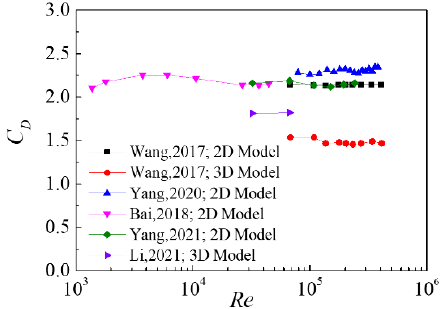
Figure 6. C D varies with Reynolds number [14,16,17,20,21].